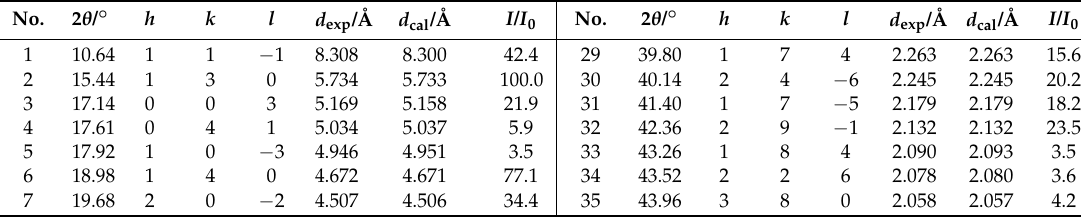
Table 1. Experimental data and calculated results for XRD of [Zn 2 (btca)(H 2 O) 4 ].